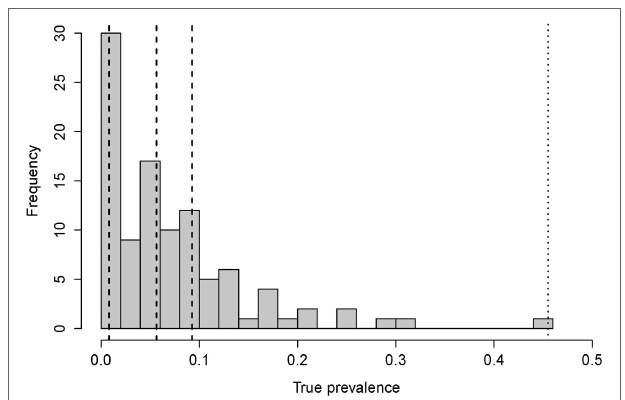
FIGURE 1 | The distribution of the true prevalence calculated for 102 randomly chosen herds in Denmark . The dashed lines show the 25, 50, and 75 percentiles (at 0.8, 5.6, and 9.3% prevalence, respectively), and the dotted line show the maximum observed prevalence